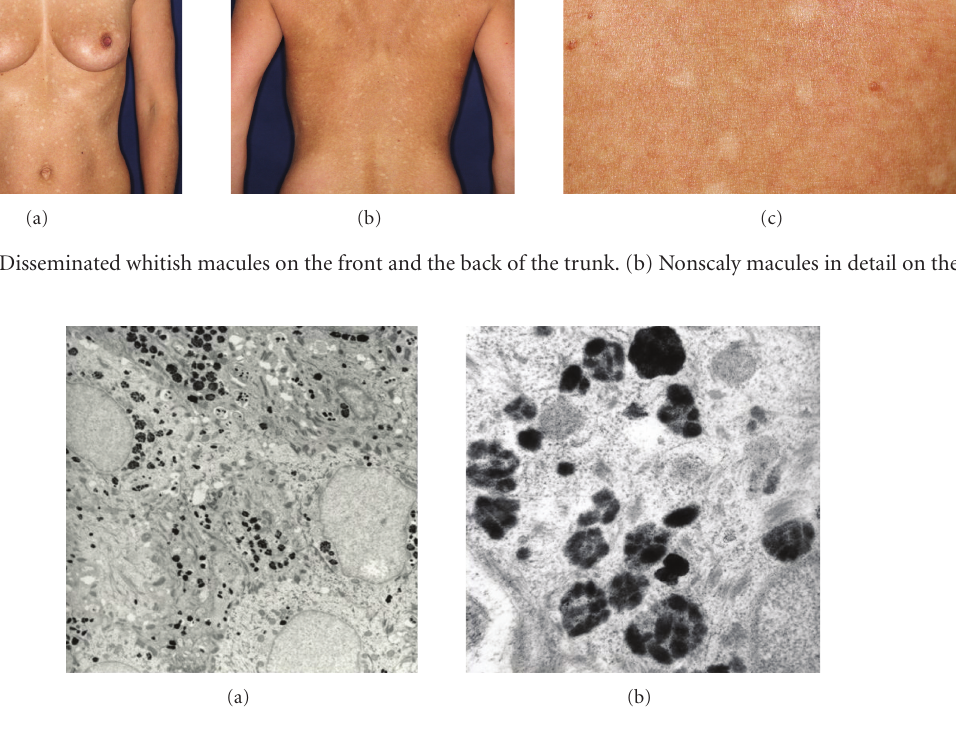
Figure 2: Electron microscopy of non-a ff ected skin . Left (8:300 × ): numerous melanosomes aggregated in big clusters and disseminated melanosomes. Right detail (49:800 × ): Granular melanosomes mostly grade